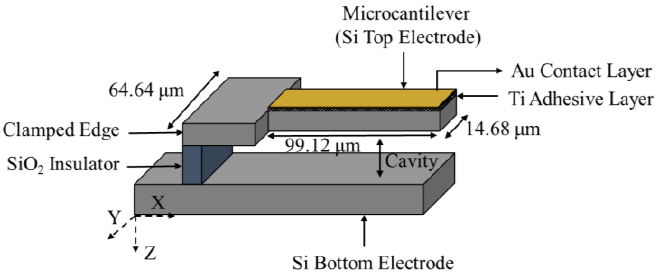
Figure 9. Schematic view of a step-optimized microcantilever structure (image not to scale).